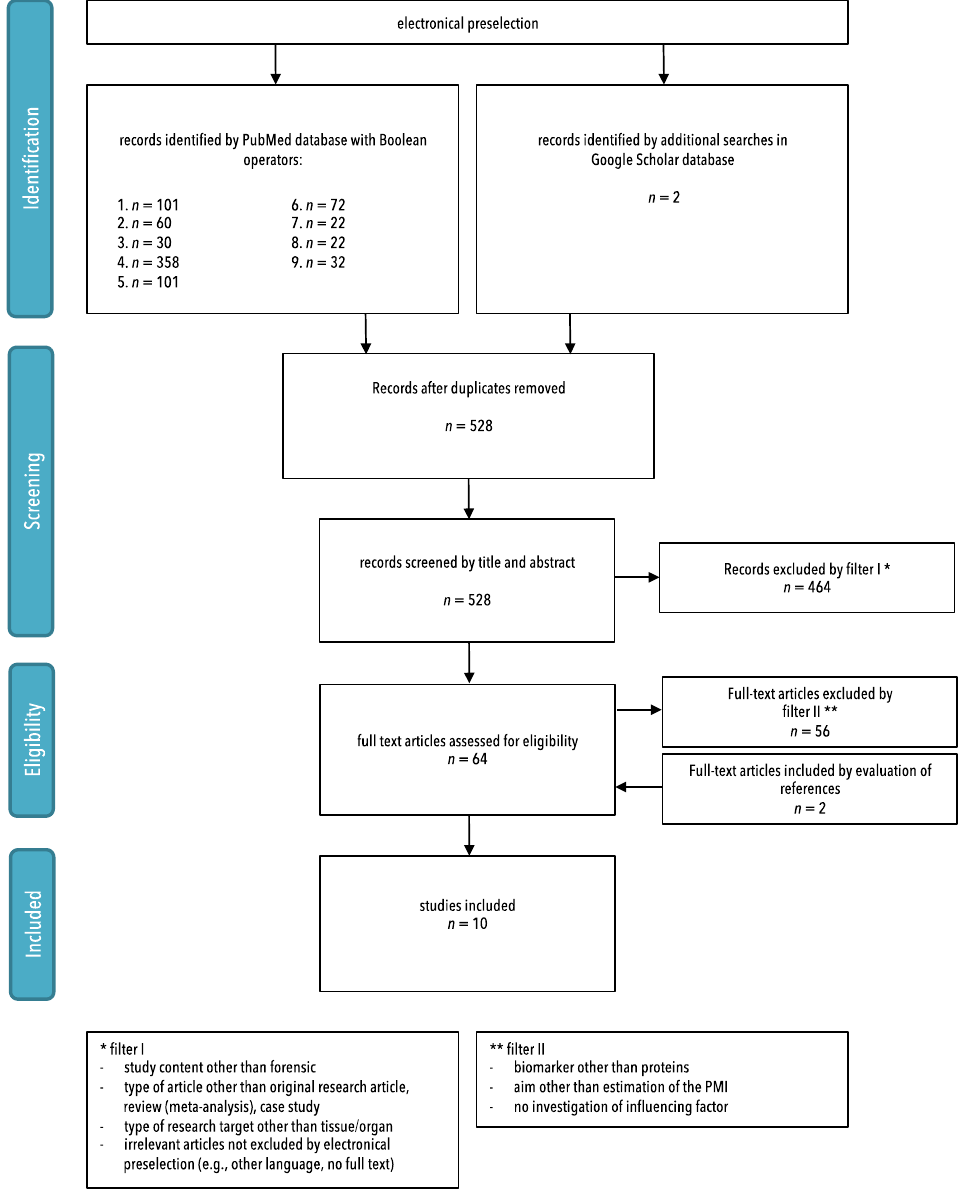
Figure 1. Flow chart of the systematic literature search according to PRISMA guidelines.